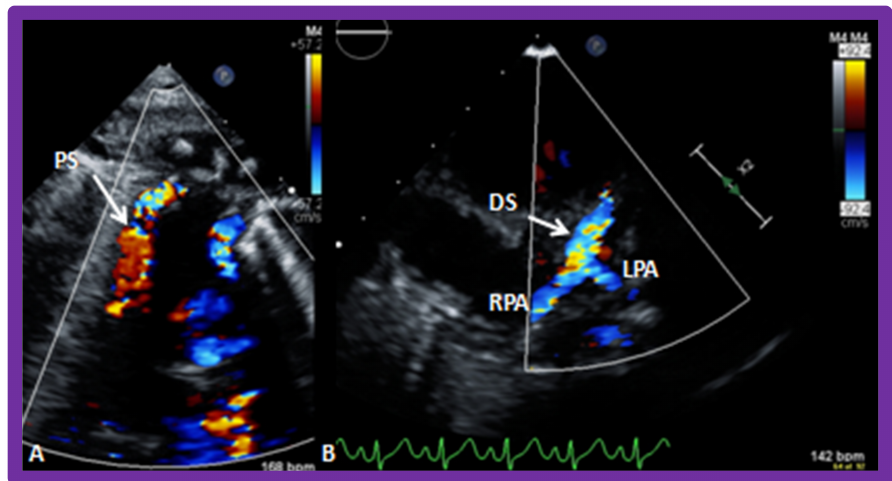
Figure 8. Selected video images secured with the transducer positioned in the suprasternal notch illustrating the proximal part of the shunt (PS) with color Doppler ( A ). In another transducer angulation ( B ), the Doppler flow from the distal portion of the shunt (DS) into both the right (RPA) and left (LPA) pulmonary arteries is imaged. Reproduced from Reference [26].